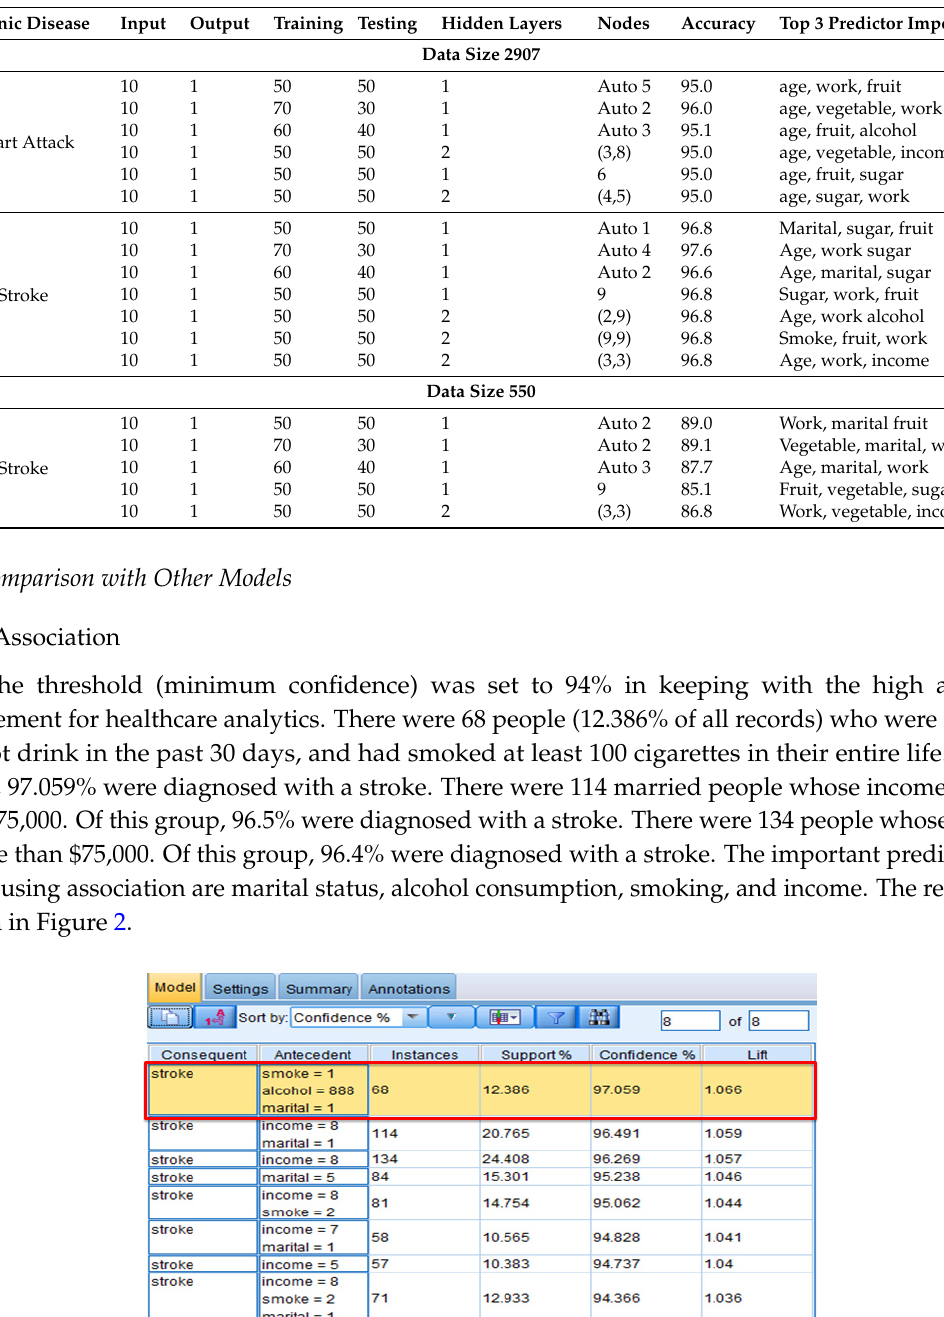
Table 2. Summary of Neural Network analyses